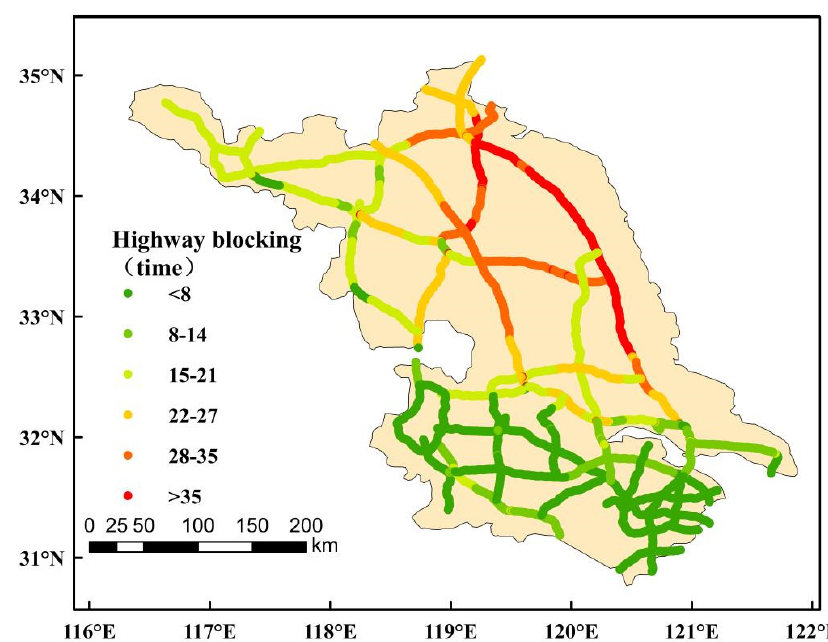
Figure 4. Spatial distribution of highway ‐ blocking events in Jiangsu Province in 2020.